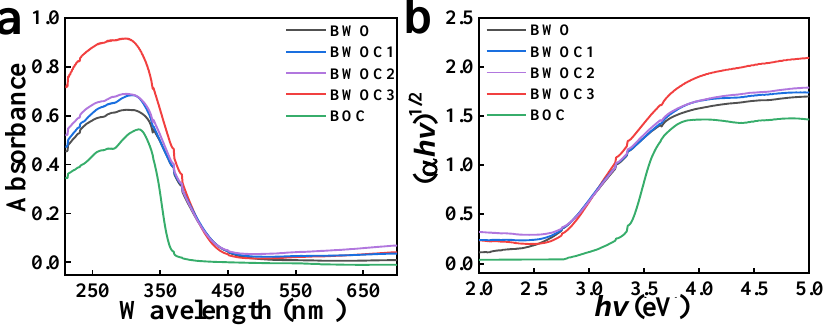
Figure 3. ( a ) UV–Vis diffuse reflectance spectra and ( b ) Tauc curves of the as-prepared samples. ( αhv ) 1/n = A( hv − E g )